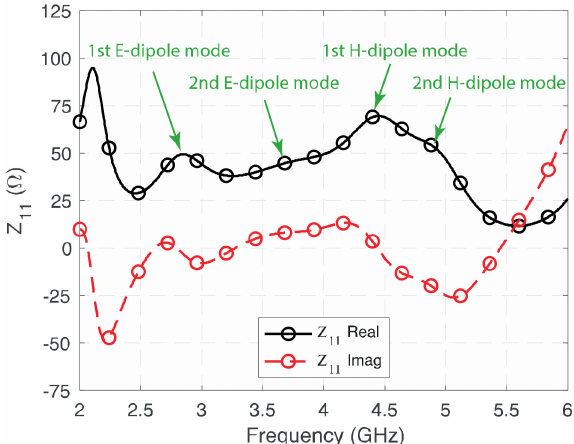
Figure 3. Simulated Z 11 of the proposed wideband CP cavity-less ME dipole antenna.